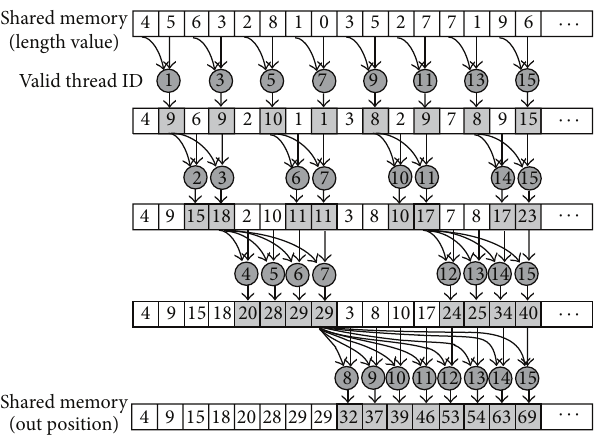
Figure 11: Parallel writing packing.